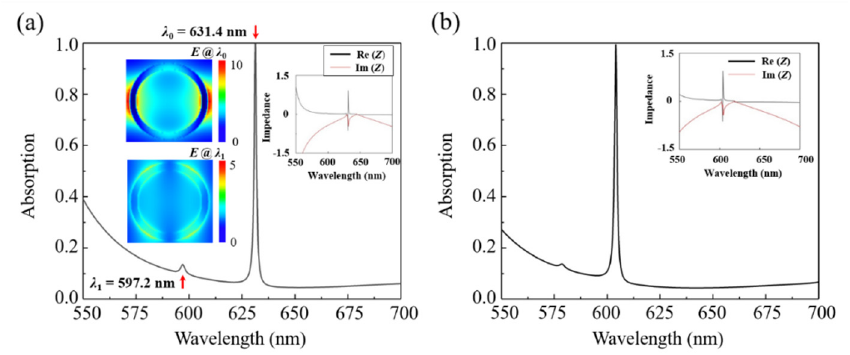
Figure 2. ( a ) Simulated absorption spectra for the proposed α -MoO 3 absorber structure along the [100] directions. ( b ) Simulated absorption spectra for the proposed α -MoO 3 absorber structure along the [001] directions. The subgraphs of Figure 2 represent the calculated real and imaginary parts of the effective impedance along the [100] and [001] directions, respectively.